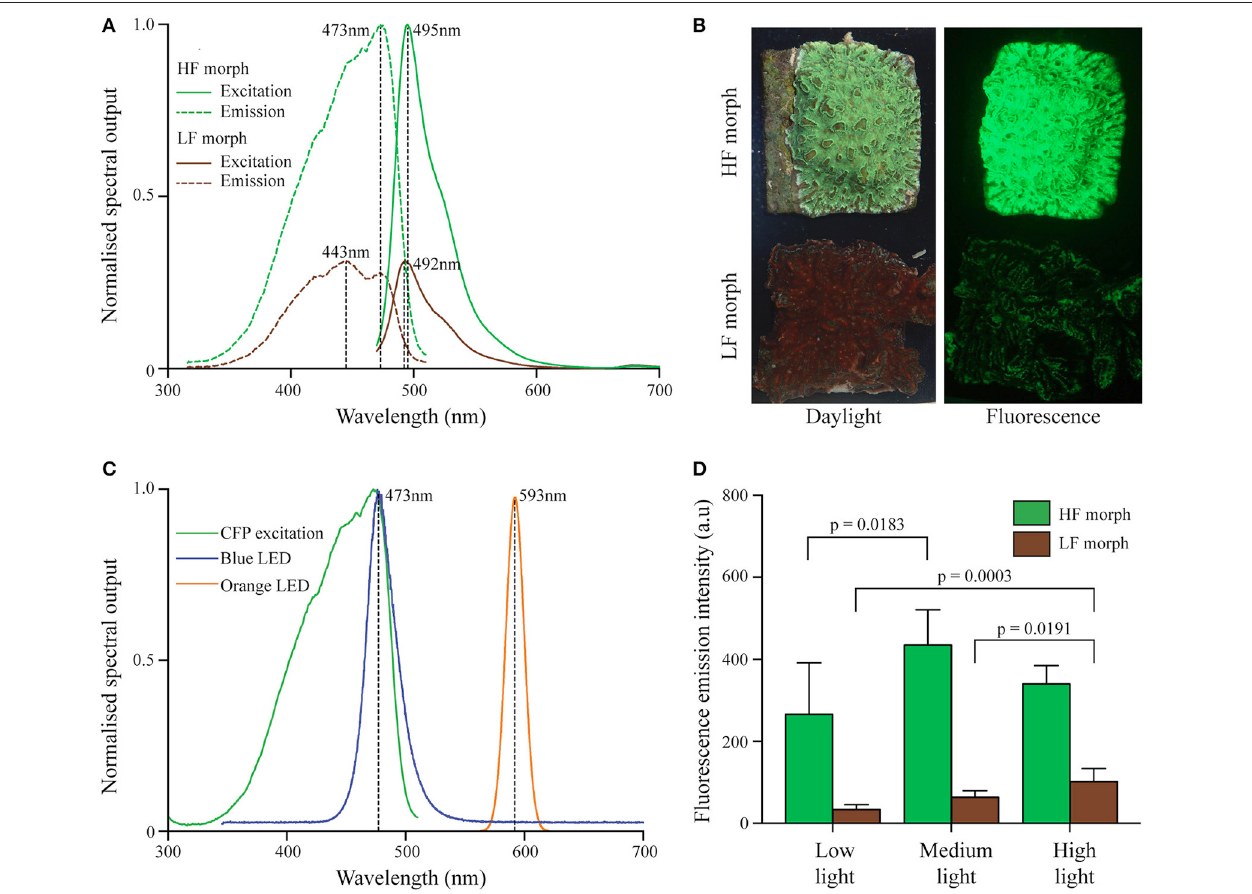
FIGURE 1 | (A) Excitation and emission spectra of two color morphs of Hydnophora grandis . Peak maxima indicated by dashed vertical lines with peak wavelengths (nm) being indicated. Excitation spectra are scaled to the maximum of the corresponding emission spectra. (B) Photographs of representative colonies of HF (top) and LF (bottom) morphs under daylight (left) and blue light excitation ( ∼ 470nm; imaged with a yellow long-pass filter) (right). (C) Emission spectra of blue LED (blue line) and orange LED (orange line) used in aquarium experiments. The CFP excitation spectrum of the HF morph is included for comparison (green line). (D) Fluorescence emission intensity (measured at the peak wavelength) of both morphs at the end of each experiment under low (10 µ mol photons m − 2 s − 1 ), medium (300 µ mol photons m − 2 s − 1 ), and high (1,100 µ mol photons m − 2 s − 1 ) intensities of blue light. Bars display mean values of 5 colonies. Error bars show standard deviation. Brackets above two bars indicate p -values for statistically significant ( p < 0.05) differences between the fluorescence emission intensity of each morph at the end of each treatment, determined by one-way